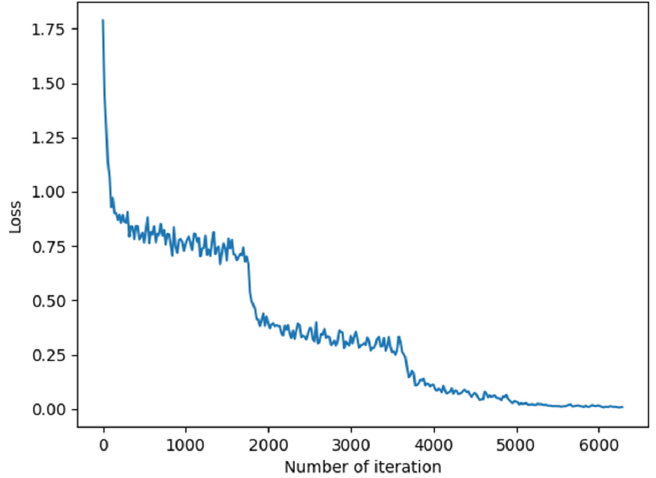
Figure 6. Loss of binarization model experiment.